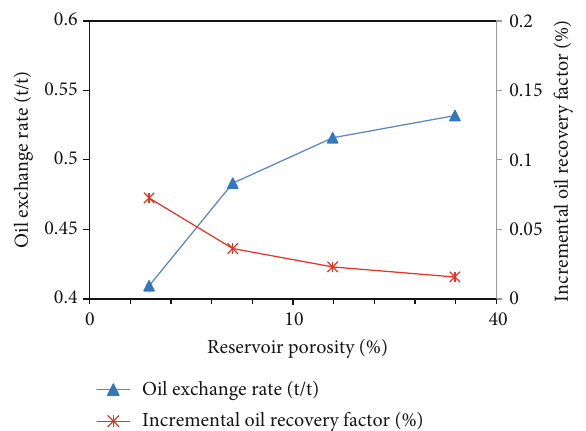
Figure 12: Incremental oil production and oil exchange rate through CO hu ff -n-pu ff under di ff erent fracture half-lengths of 2 the horizontal well.